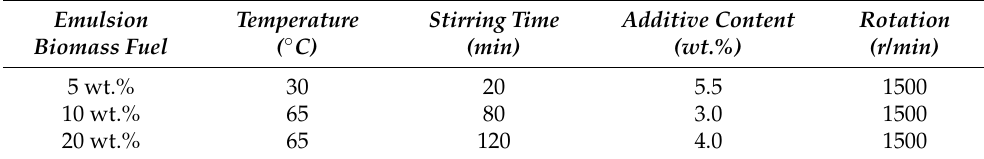
Figure 2. Appearance of different emulsified biomass fuels. Table 1. Optimal preparation parameters of varied biomass fast pyrolysis fuel and diesel